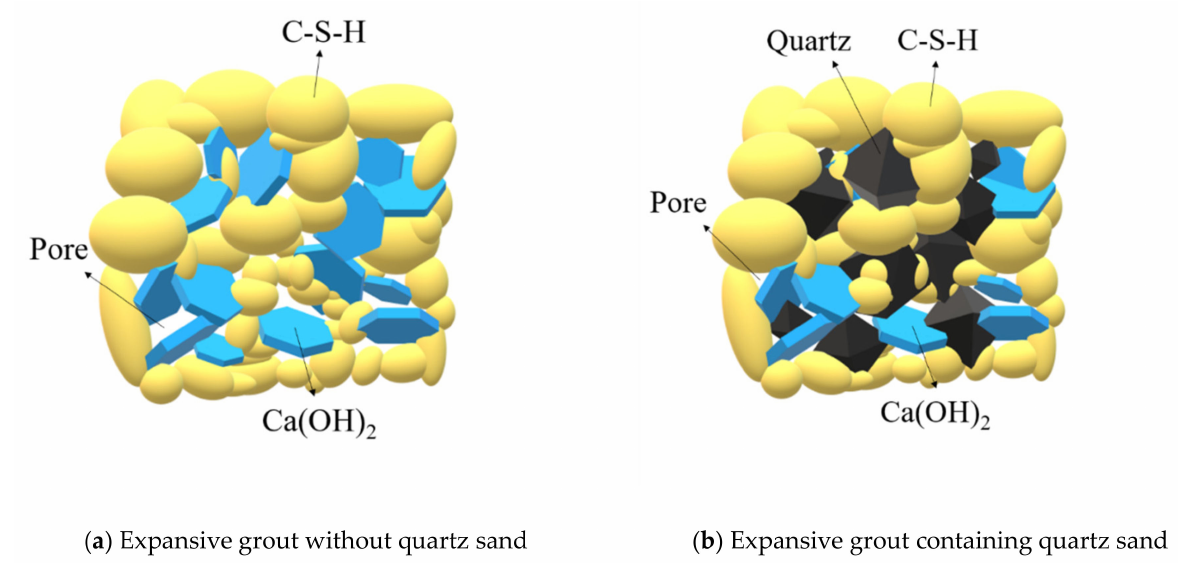
Figure 11. Strength enhancement mechanism of quartz in expansive grout.